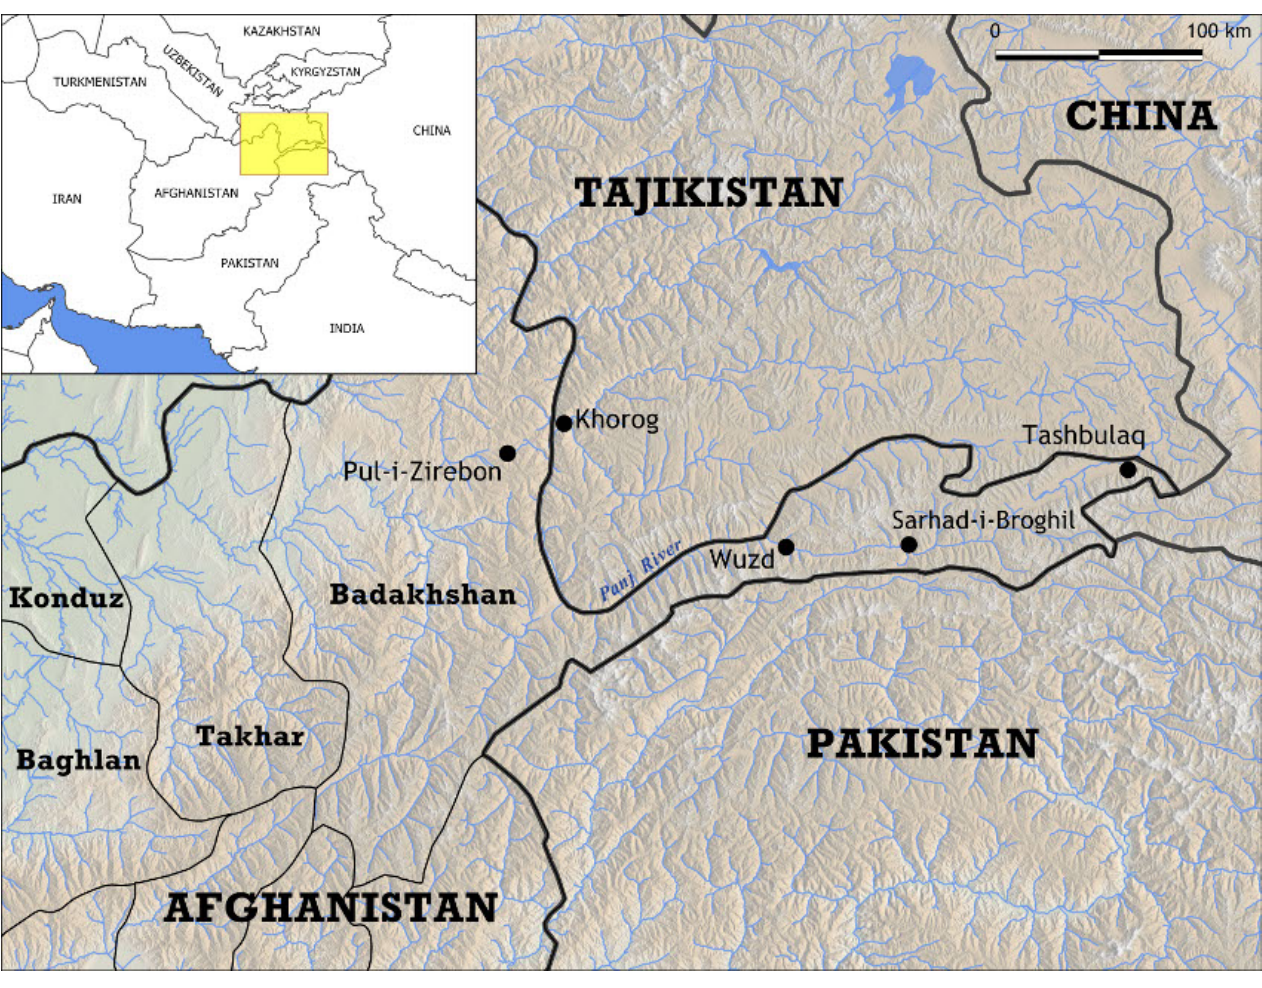
Fig. 1 . Map of research area in the Pamir Mountains of Afghanistan (and Tajikistan) in Central